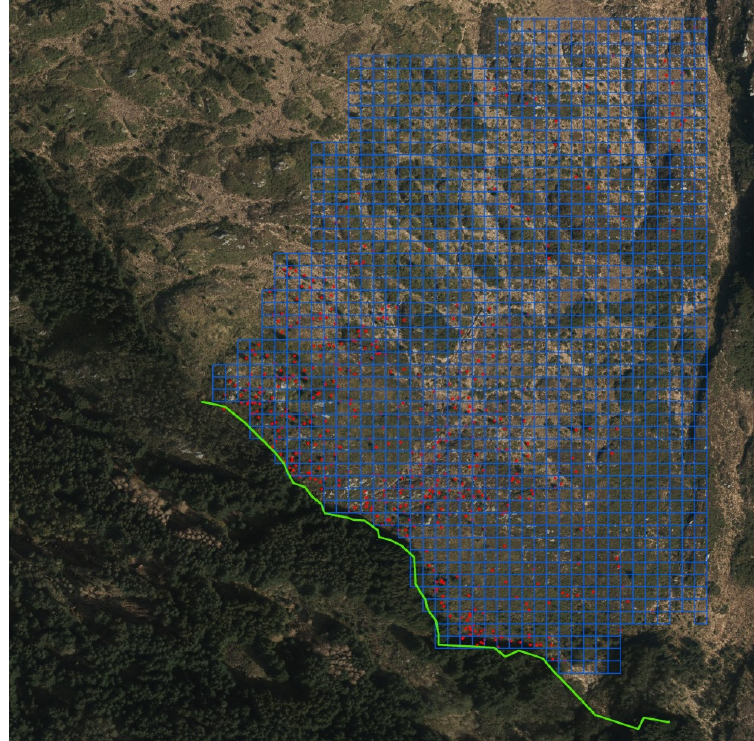
Figure 1. Orthophoto showing the Strandafjellet study site. The green line shows the seeding edge of the parent stand. Each spruce sapling position is shown as a red point. The grid size is 10 × 10 m. This mapping design was applied for all sites.